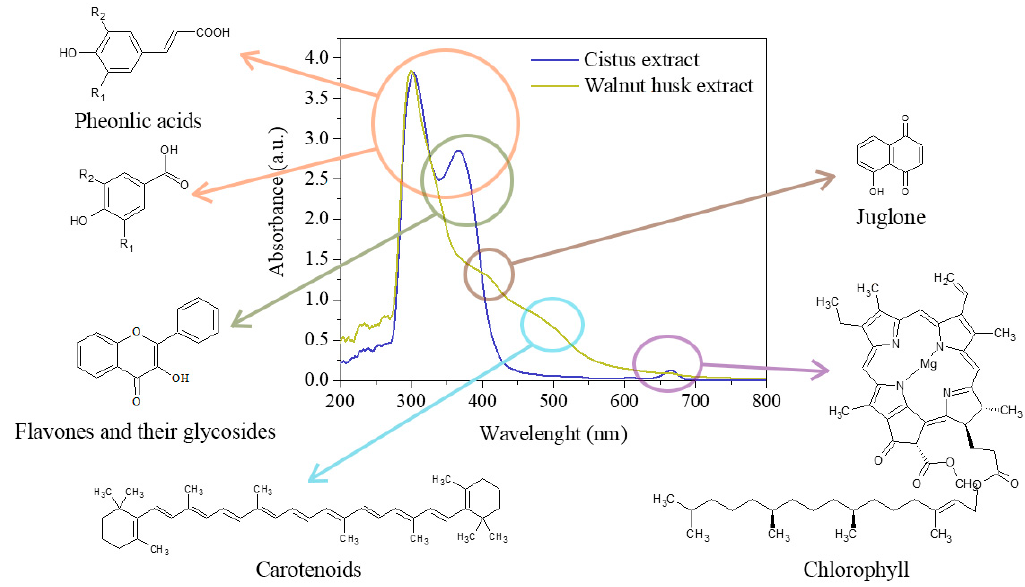
Figure 3. The UV–Vis spectra of the extracts of Cistus and walnut husk. Figure 3. The UV – Vis spectra of the extracts of Cistus and walnut husk. Table 1. Antioxidant activity and ability to reduce transition metal ions of the extracts of Cistus and walnut